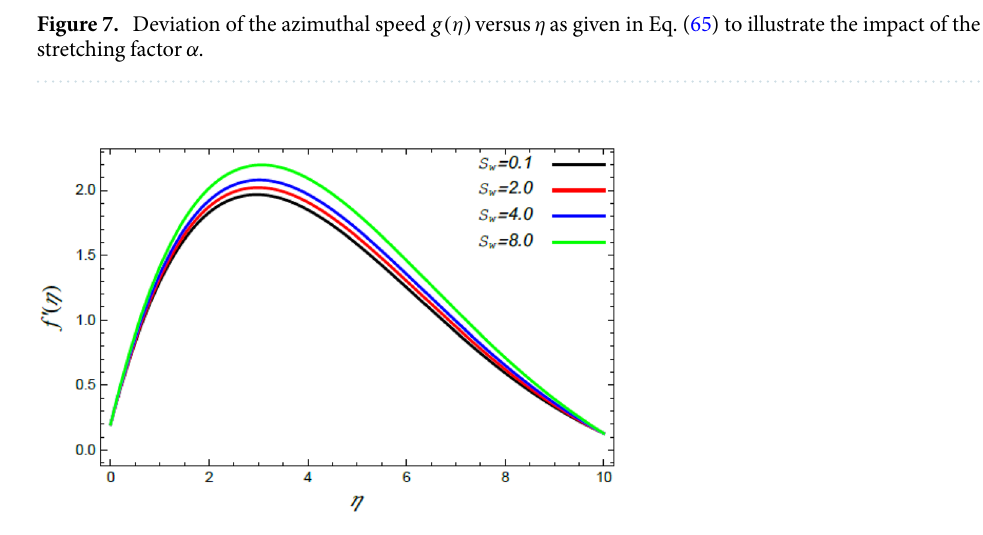
Figure 8. Deviation of the radial speed f ′ (η) versus η as given in Eq. (64) to illustrate the impact of the Stefan blowing factor S w